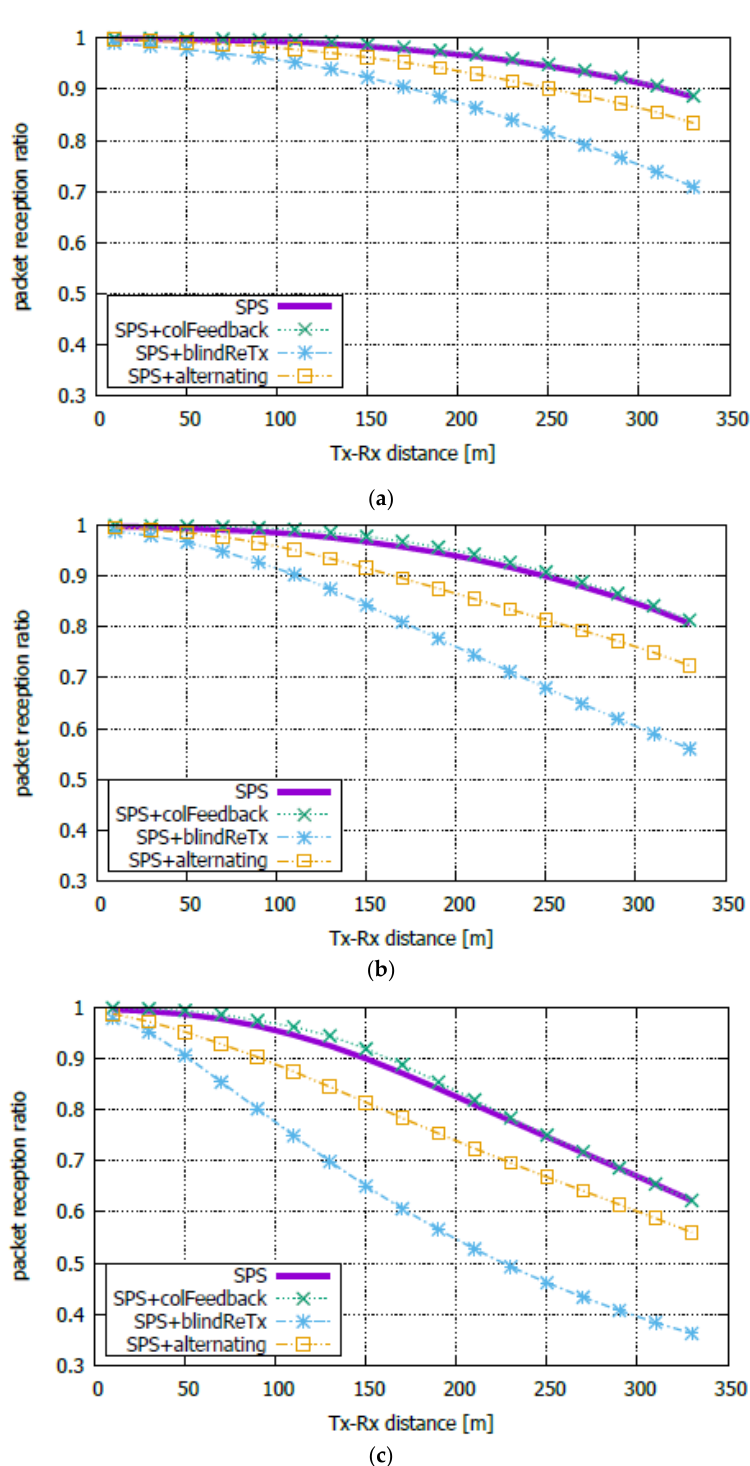
Figure 11. Packet reception ratio comparison. ( a ) ρ = 100; ( b ) ρ = 150; ( c ) ρ = 200